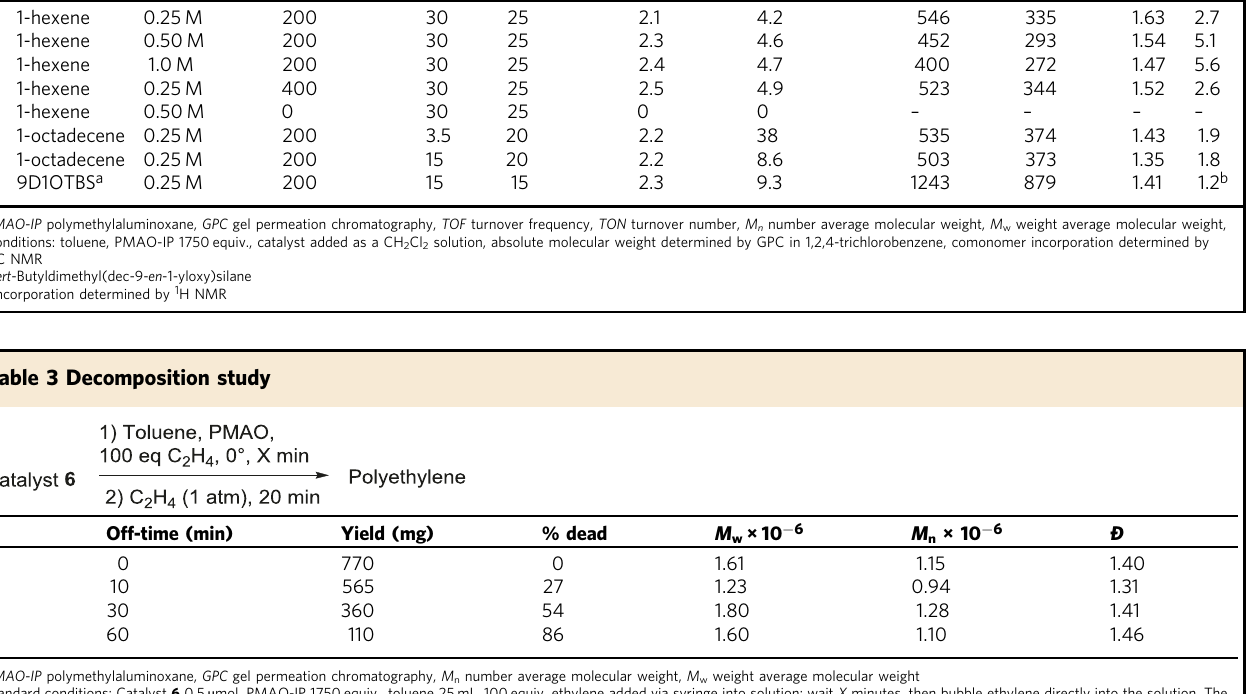
Table 2 Copolymerization of ethylene with α -ole fi ns # Comonomer Concentration Ethylene